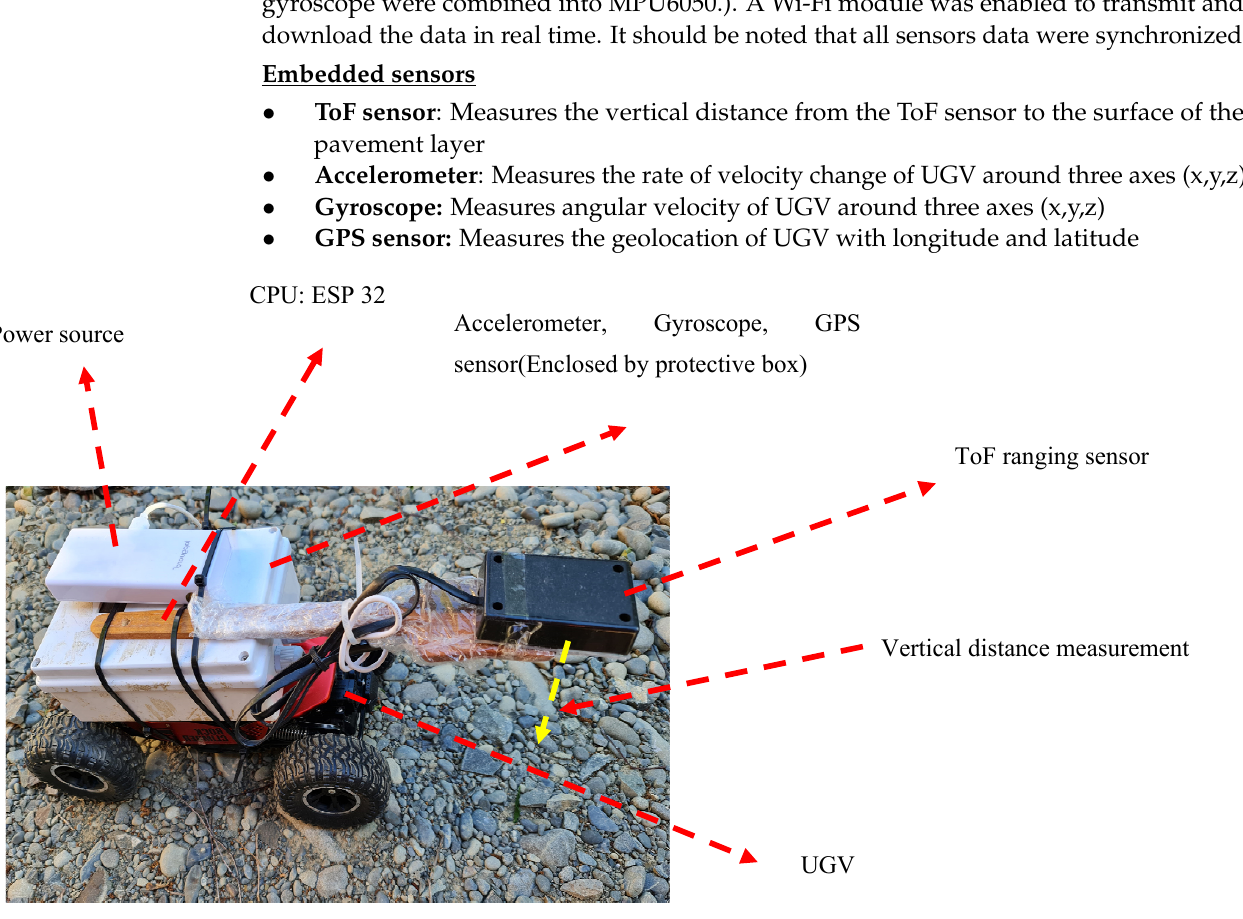
Figure 3. Sensors mounted on UGV for data collection .